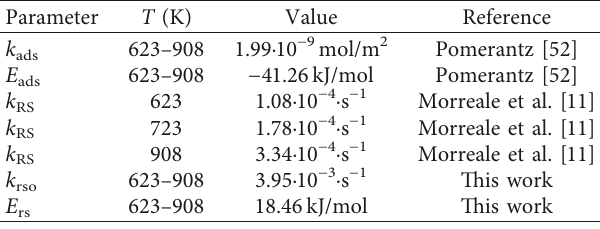
Table 1: Summary of calculated hydrogen sulfide parameter values.